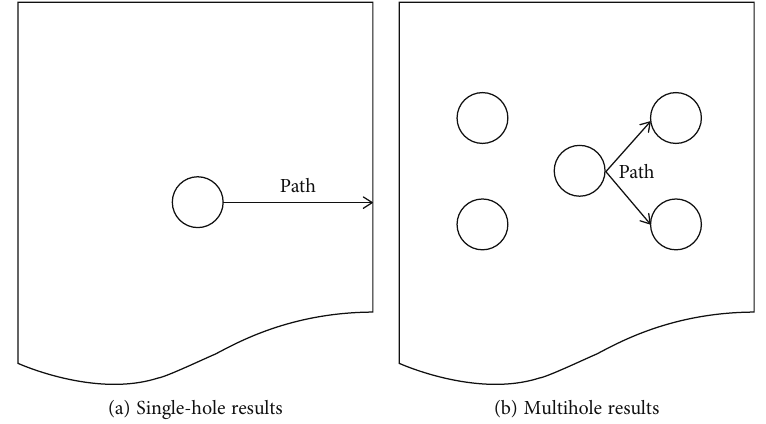
Figure 14: Simpli fi ed dangerous